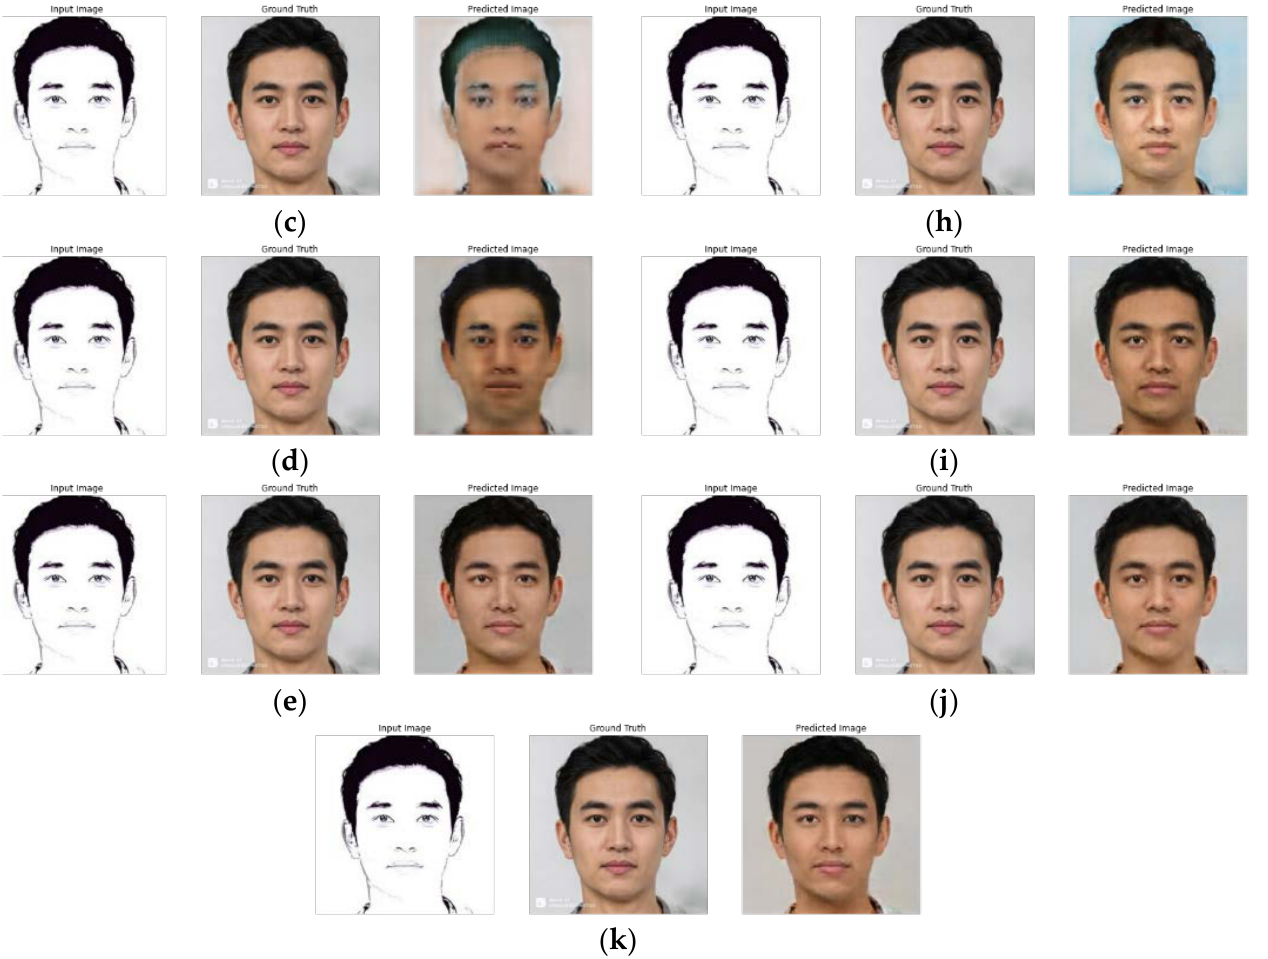
Figure 3. Visual result of each scenario. ( a – k ) Visual result of scenario a–k, respectively; ( g ) is the result of pix2pix (baseline method) [8]. The ground truth images are from generated photos [17].